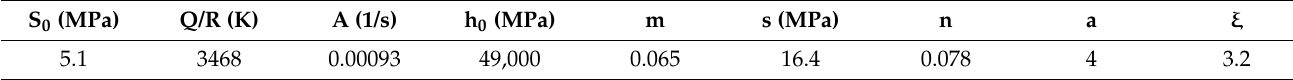
Table 3. Anand Parameters of Sn3.0Ag0.5Cu solder [18].